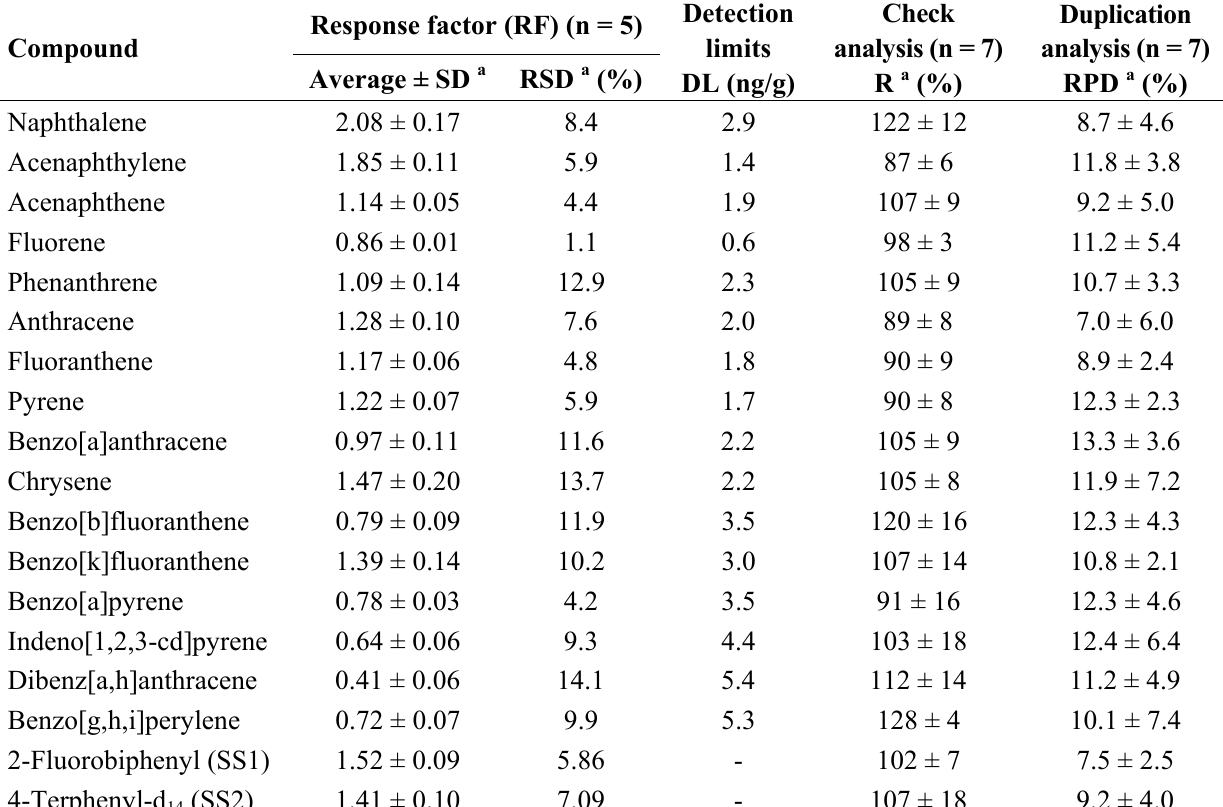
Table 2. Response factor, detection limits, recoveries of check standards, and relative percent differences of sample duplicates for individual PAHs in this